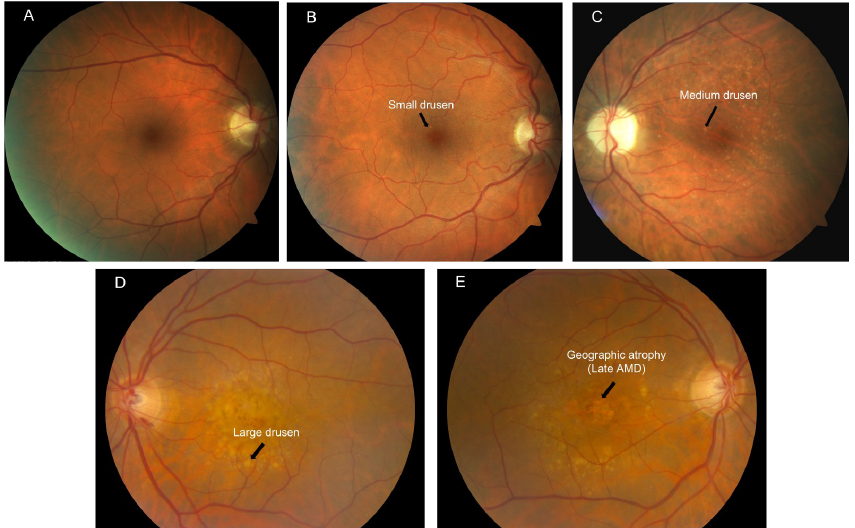
Figure 2. Illustration of the Beckman’s clinical classification of AMD based on color fundus photos. ( A ) No apparent aging changes; ( B ) Normal aging changes; ( C ) Early AMD; ( D ) Intermediate AMD; ( E ) Late AMD evidenced by geographic atrophy.